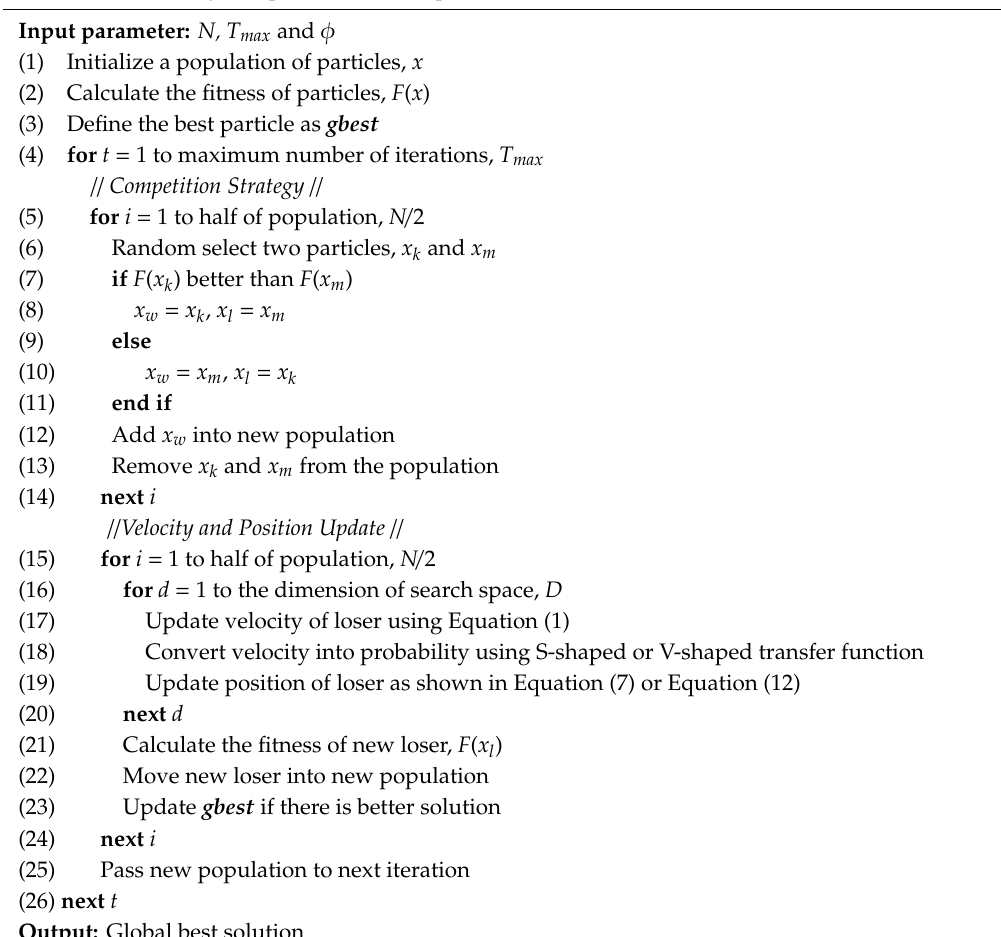
Algorithm 2. Binary competitive swarm